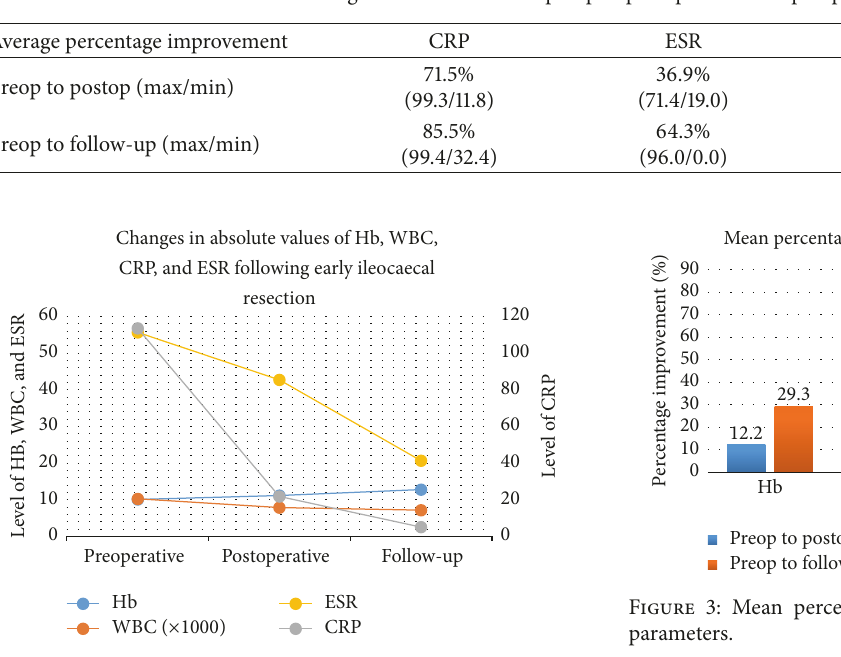
Figure 2: Comparative chart displaying the improvements in the values of the measured values.